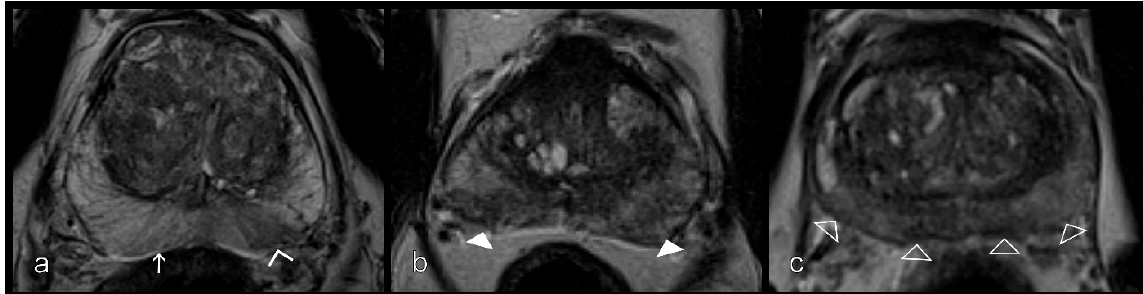
Figure 3. Inflammatory changes in the peripheral zone from left to right. ( a ) Stripes (white arrow) and sharp wedges (empty arrowheads), ( b ) wedges with obscured margins (white arrowheads), and ( c ) patchy and diffuse signal reduction (empty arrowheads) on T2W sequences.